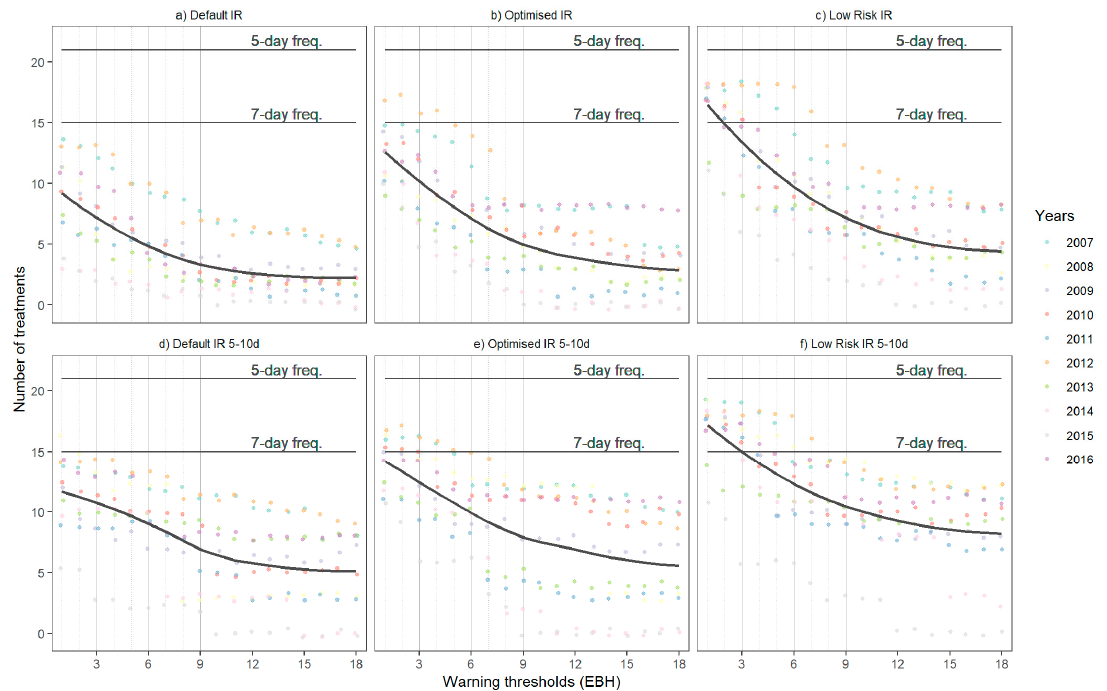
Figure 7. Di ff erence between the model guided and the standard grower practice number of treatments over the range of decision thresholds. Figures ( a – c ) depict the sums of guided model; ( d – f ) the model and calendar guided number of treatments per year. The dots represent the number of treatments per corresponding warning threshold in each year. LOESS curve represents the average potential benefit from the use of the model. The 5 and 7-day lines represent number of treatments per estimated crop season. If the fitted smoothed line is above the estimated calendar frequency line, the model recommends more treatments than the usual standard calendar program, on average.